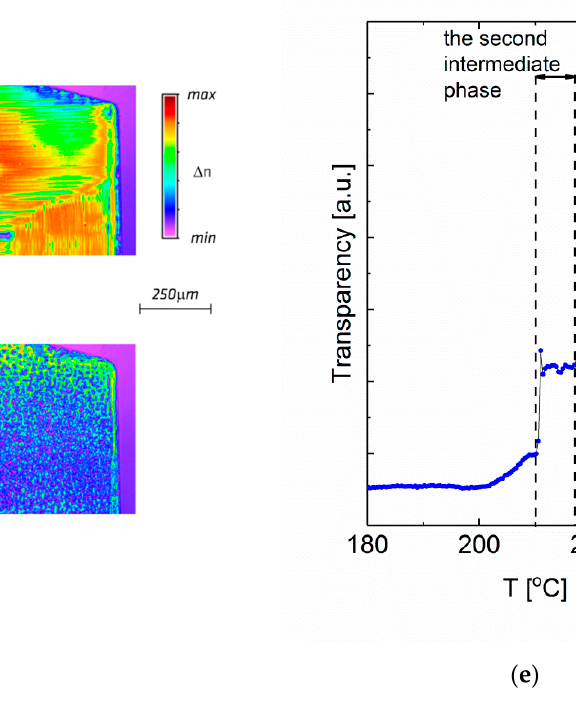
Figure 4. Birefringence maps of PbZrO 3 single crystals with the nominal content of 0.6 mol% Nb 2 O 5 obtained in the cooling process ( a ) above T c at 235 ° C, ( b ) below T c in the first transition phase, at 229 ° C, ( c ) in the second transition phase, at 215 ° C, and ( d ) in the antiferroelectric phase, at 186 ° C. The bar with a color gradient represents birefringence values from 0 (pink) to the highest value (red) [32]. The Figure 4( e ) shows the dependence of light absorption at 570 nm wavelength in PbZrO 3 with an admixture of nominal amount of 1 mol% Nb 2 O 5 as a function of temperature in the cooling process, for wavelength λ = 570nm [33].